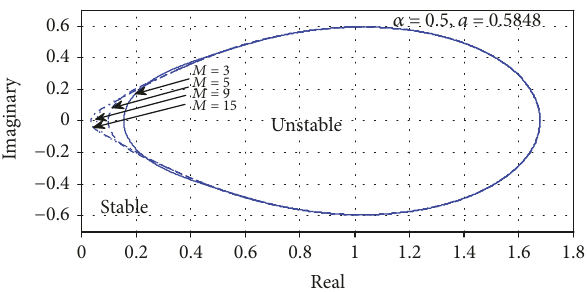
Figure 4: Stability/instability areas for h = 1 and various M